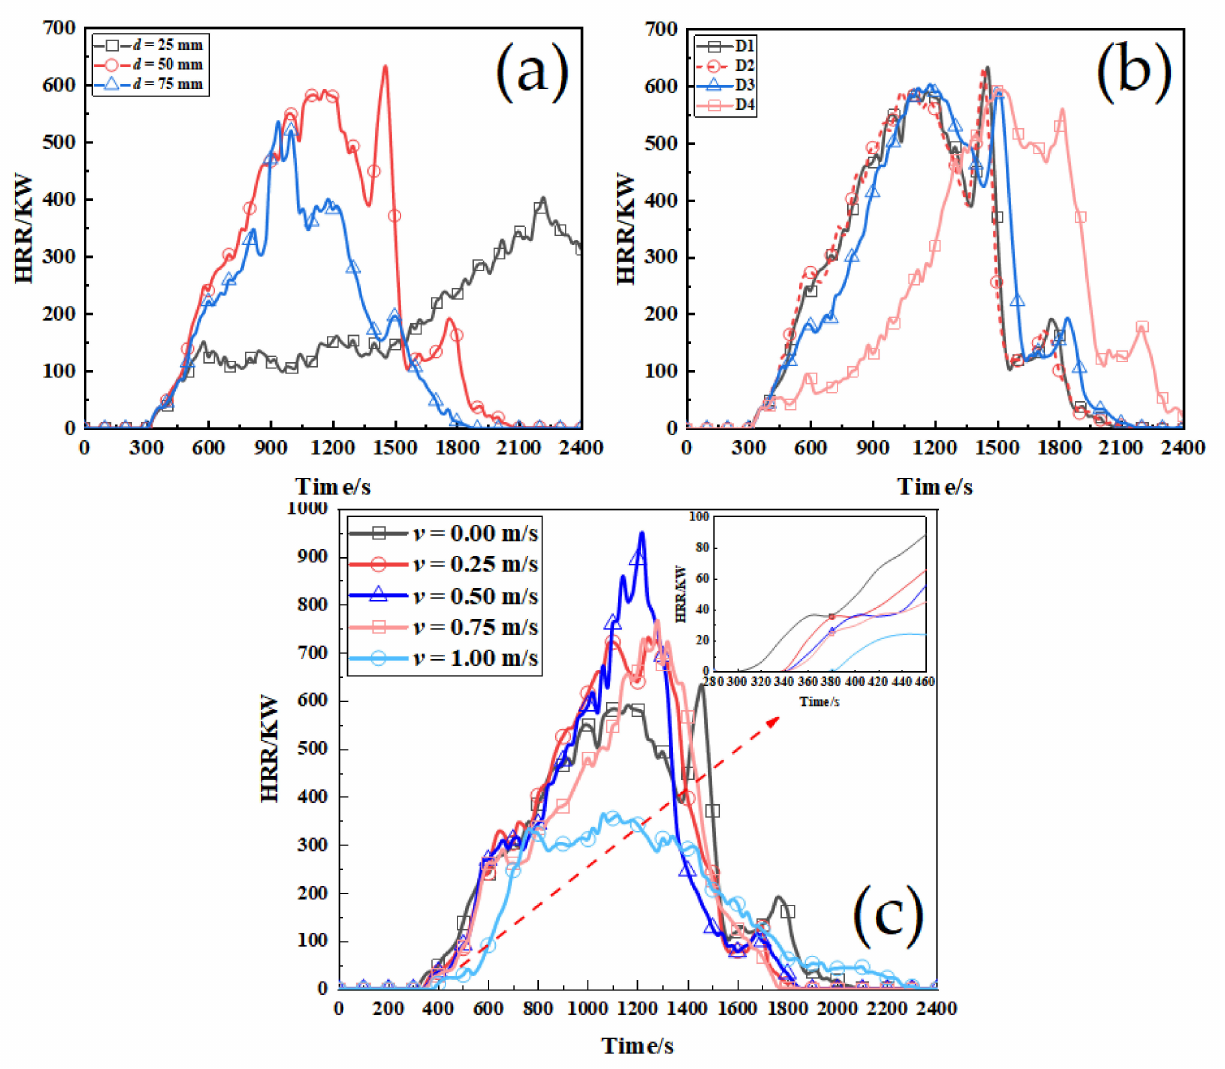
Figure 9. The heat release rate curves under different conditions: ( a ) Different cable tray spacing; ( b ) Different ignition positions; ( c ) Different wind speed.